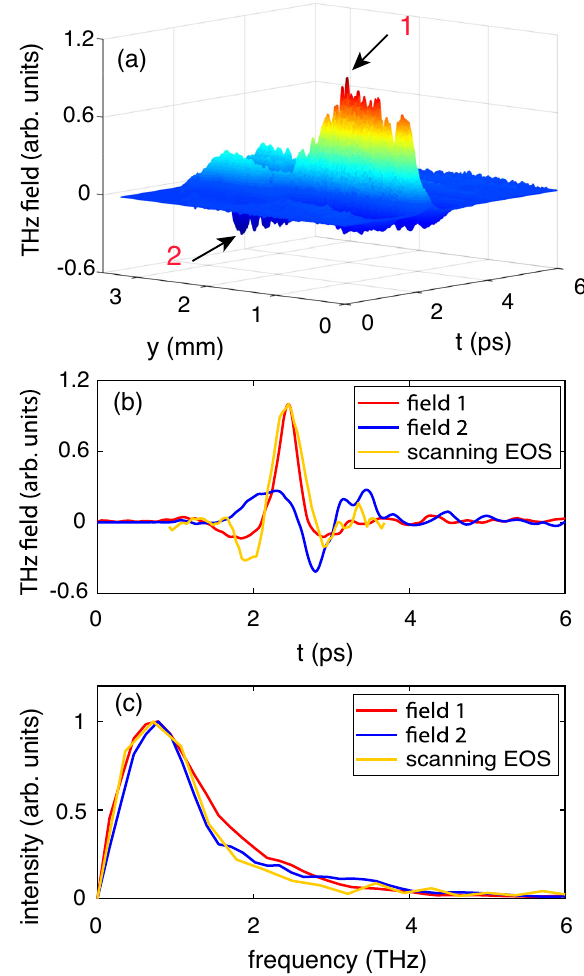
FIG. 6. (a) The spatial-temporal electric field distribution of THz radiation measured by the EO spatial decoding method at the focal plane. The temporal waveforms (b) and spectrum (c) of the THz field at position 1 (red solid line, FWHM of 310 fs), position 2 (blue solid line, FWHM of 380 fs) and scanning EOS (yellow solid line, FWHM of 360